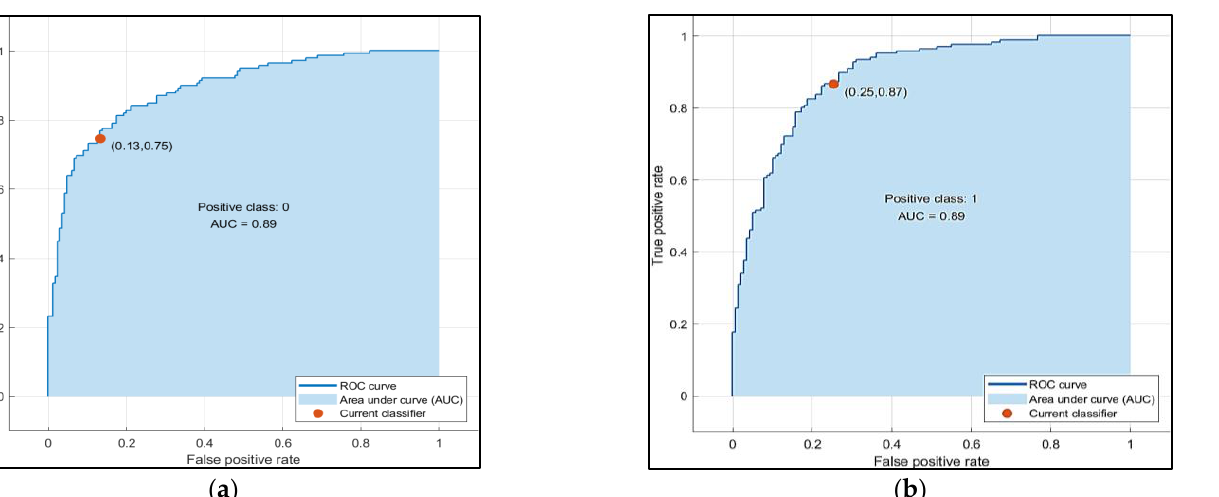
Figure 12. ( a ) Bagged tree model ROC curve corresponding to class 0. ( b ) Bagged tree model ROC curve corresponding to class 1.